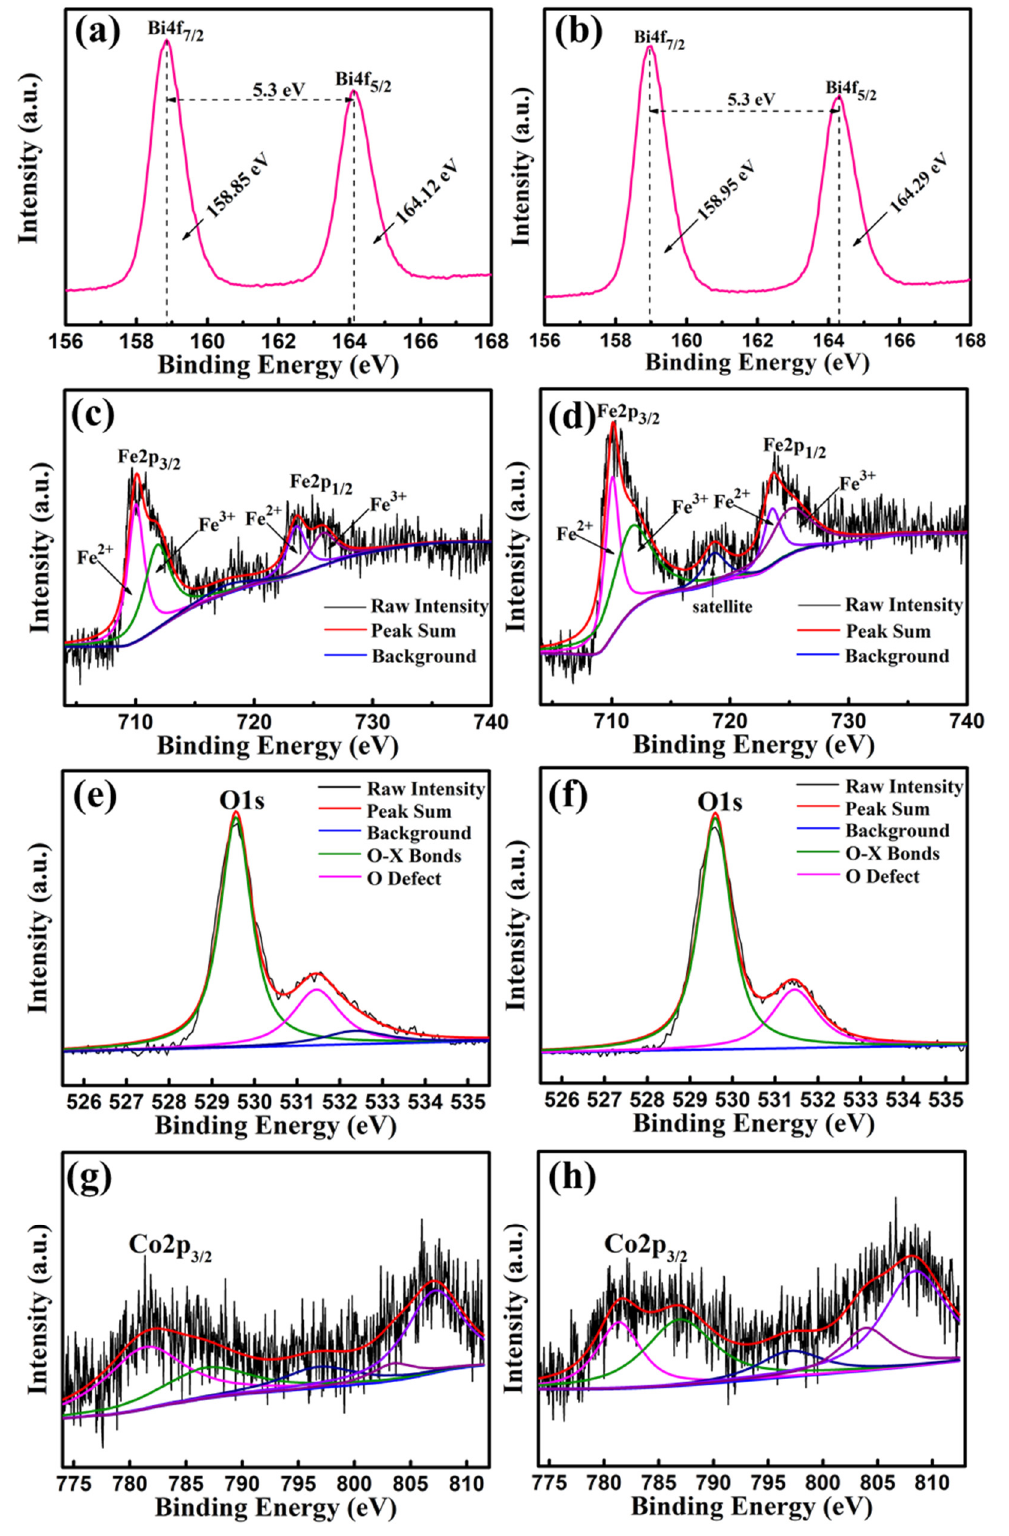
Figure 8. XPS spectra of the as-annealed BFC 0.01 O thin films in the binding energy regions of ( a ) Bi4f, ( c ) Fe2p, ( e ) O1s and ( g ) Co2p; XPS spectra of the as-annealed BFC 0.07 O thin films in the binding energy regions of ( b ) Bi4f, ( d ) Fe2p, ( f ) O1s and ( h ) Co2p.